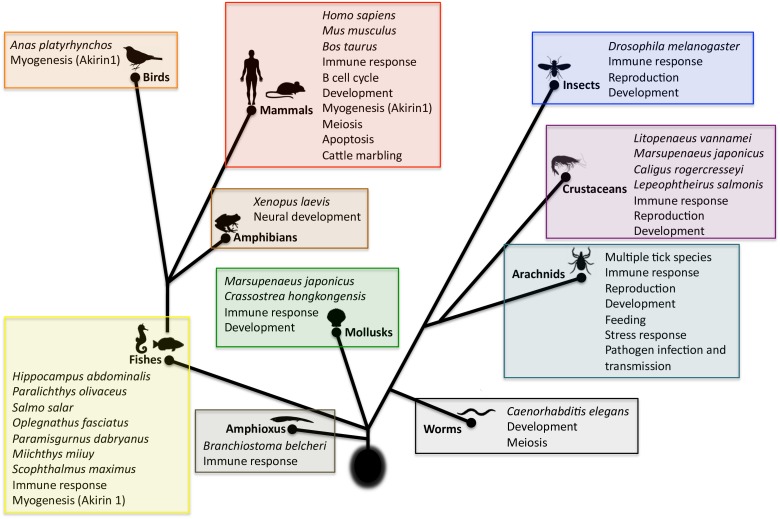
Scheme of the evolution and function of Subolesin/Akirin | Functional annotations were done based on published results for Subolesin/Akirin2. References are in the text of the paper. Myogenesis, attributed exclusively to Akirin1, was included and labeled as such. For each taxa, species in which studies were conducted are shown.